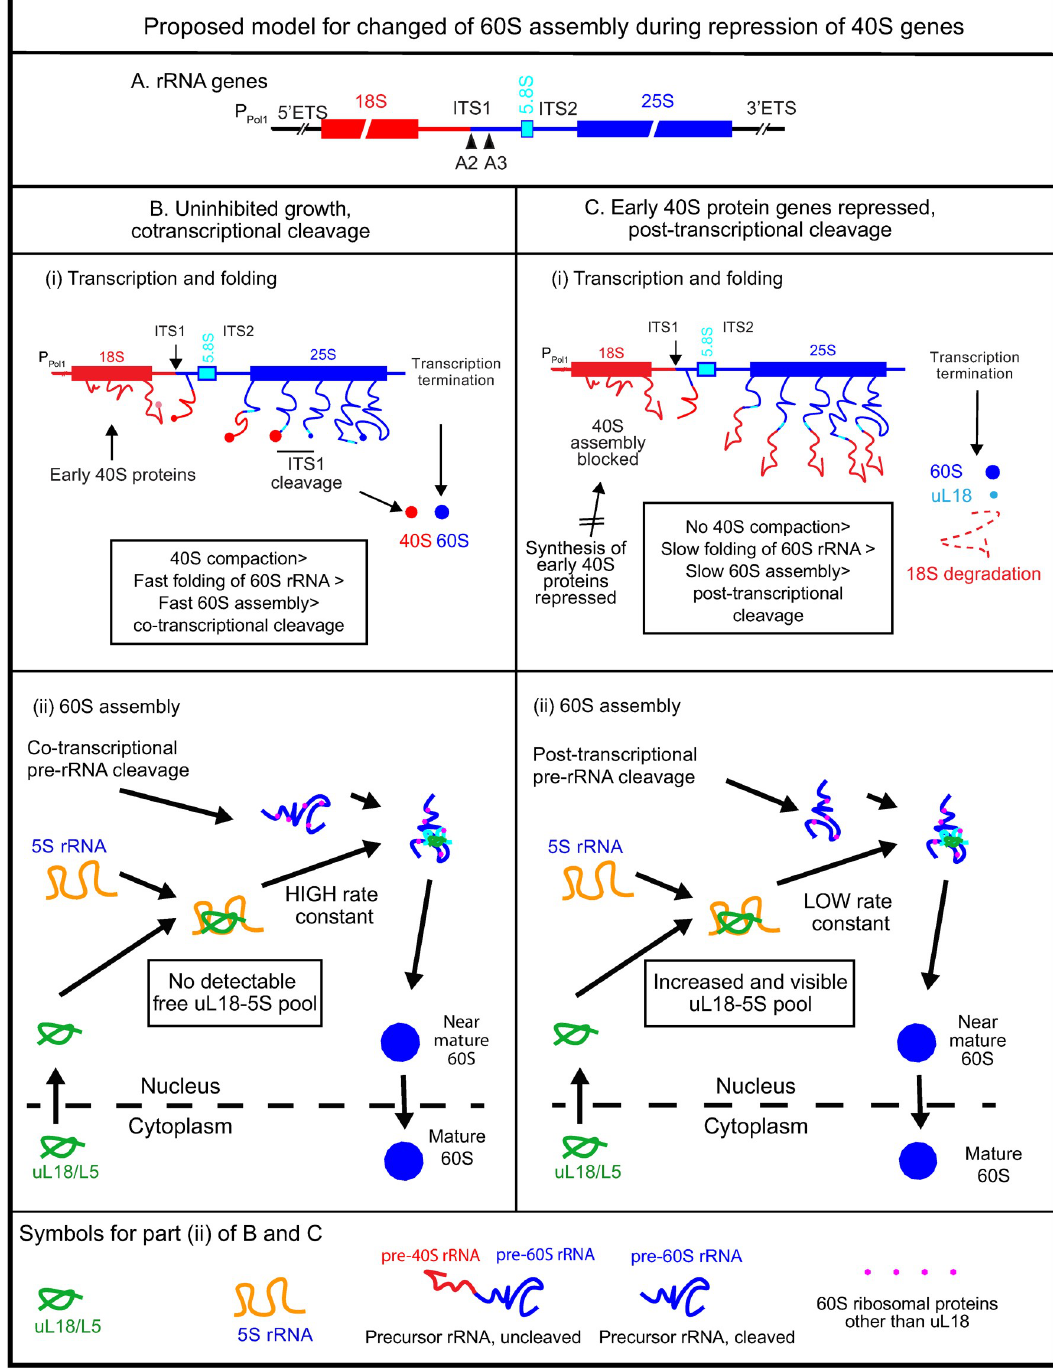
Fig 8. Model for effect of early 40S assembly on the kinetics of 60S assembly. (A) Map of the long rRNA precursor gene transcribed by RNA polymerase I. ETS: External Transcribed Spacer; ITS: Internal Transcribed Spacer; A2 cleavage site separating the pre-rRNA into subunit-specific parts. (B) Co-transcriptional rRNA cleavage during unrestricted 40S assembly. (i) Schematic representation of co-transcriptional rRNA cleavage and ribosomal assembly as revealed by electron micrographs (Miller Spreads) [30]. The 18S parts of the transcript is in red, 5.8S in turquoise, and 25S in blue. “Wiggled” lines: uncompacted rRNA complexed with assembly factors and early assembly r-proteins. Filled circles: Compacted rRNA-protein complexes; the intensity of the red color indicates the density (compaction) of the complex. (ii) Kinetic model for formation of the uL18-5S rRNA complex and incorporation into the pre-60S during unrestrained 40S assembly. We propose that the rate constant for uL18/5S rRNA binding to the pre-60S is